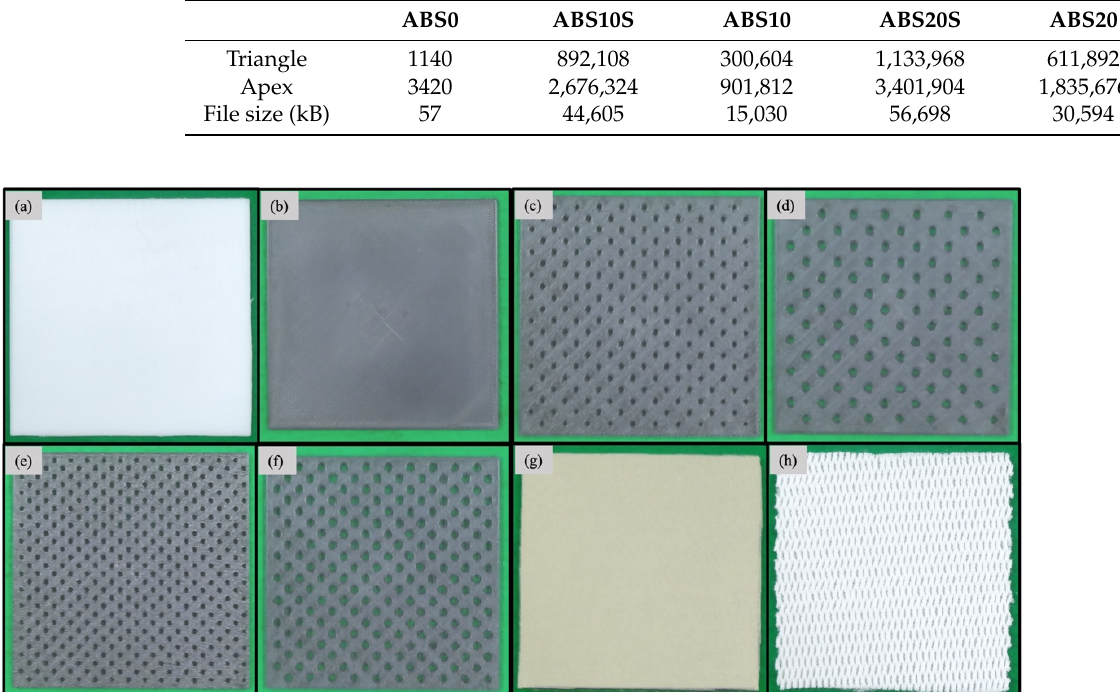
Figure 2. Specimens (100 × 100 mm 2 ) used in this study: ( a ) AP0, ( b ) ABS0, ( c ) ABS10S, ( d ) ABS10, ( e ) ABS20S, ( f ) ABS20, ( g ) NEO, and ( h ) AKE.